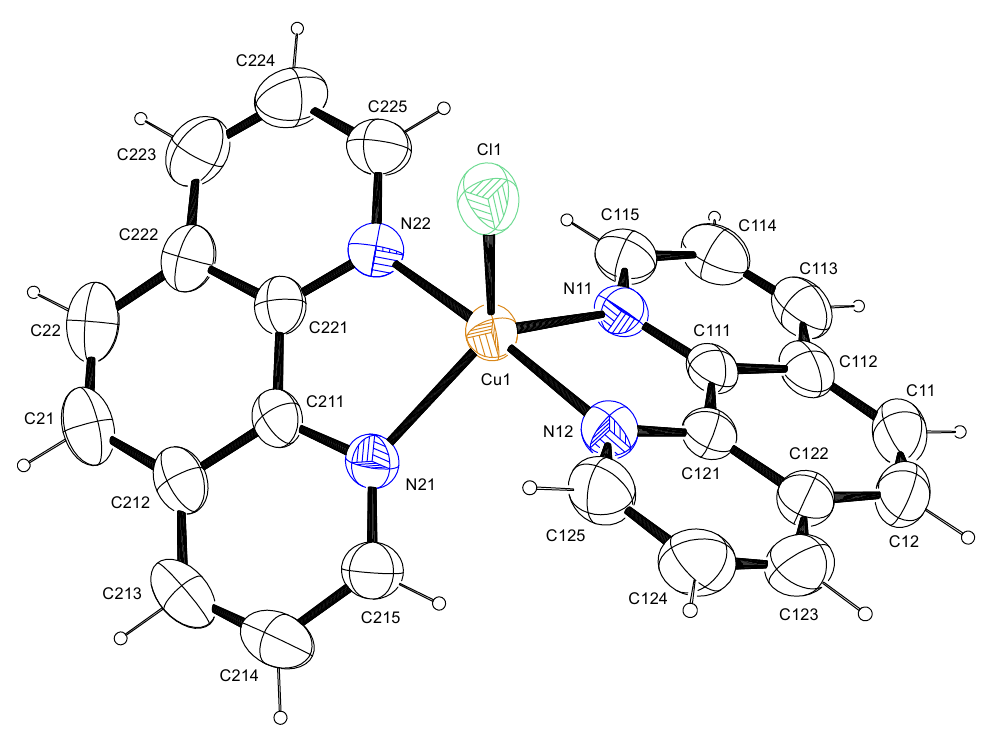
Figure 1. Labelled diagram of [Cu(phen) 2 Cl]. Ellipsoids were drawn at 50% probability level. Table 1. Selected crystal data and details for the determination of the photocatalyst.